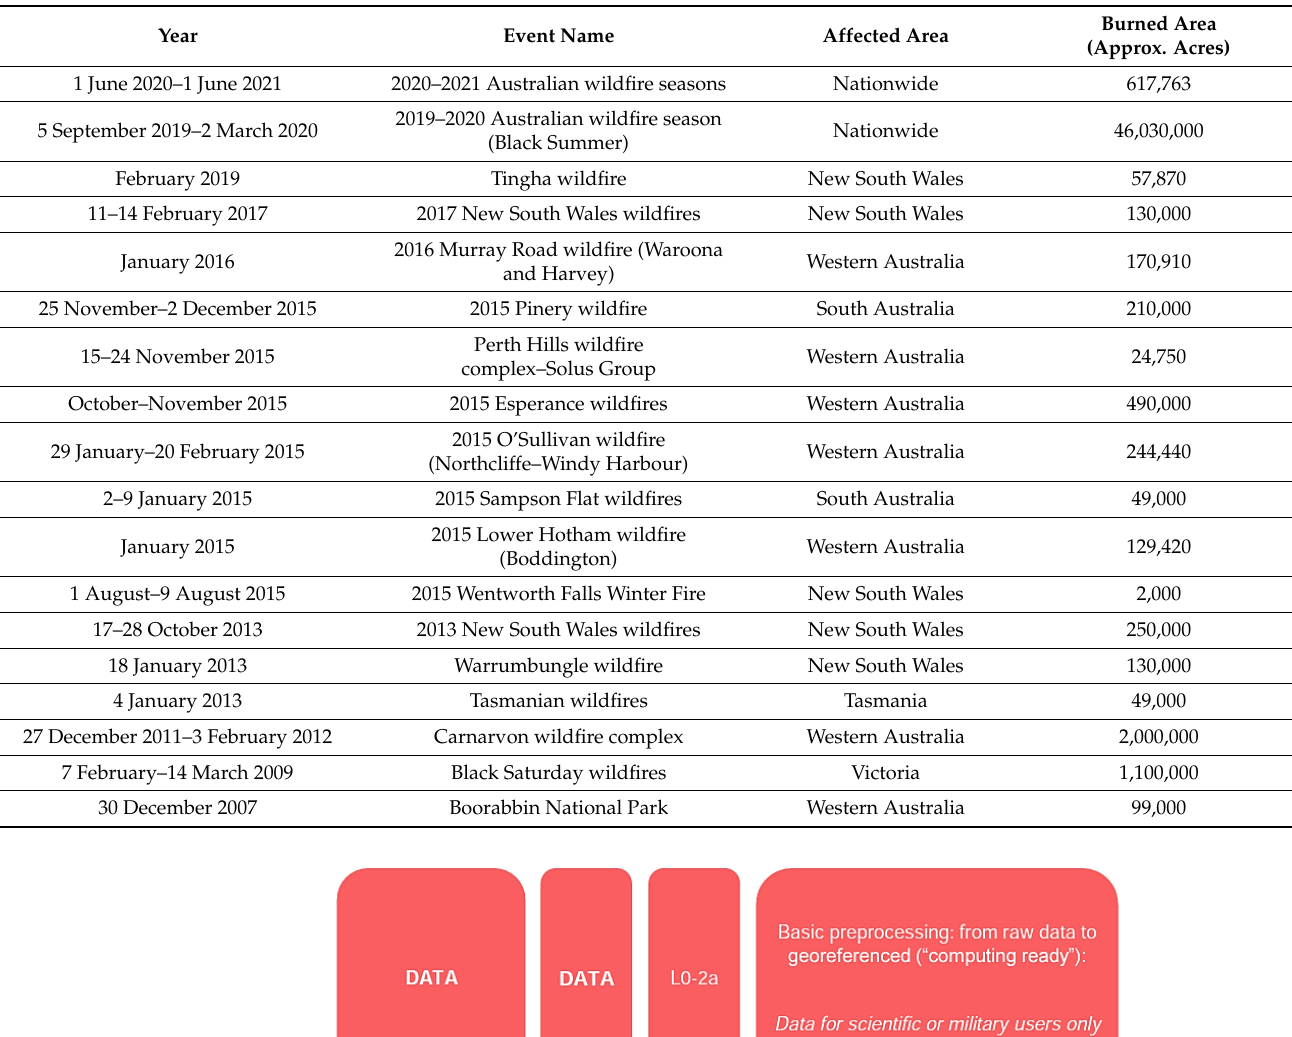
Table 4. Mos relevant wildfires that took place in Australia from 2007 to 2021 [42 – 45].